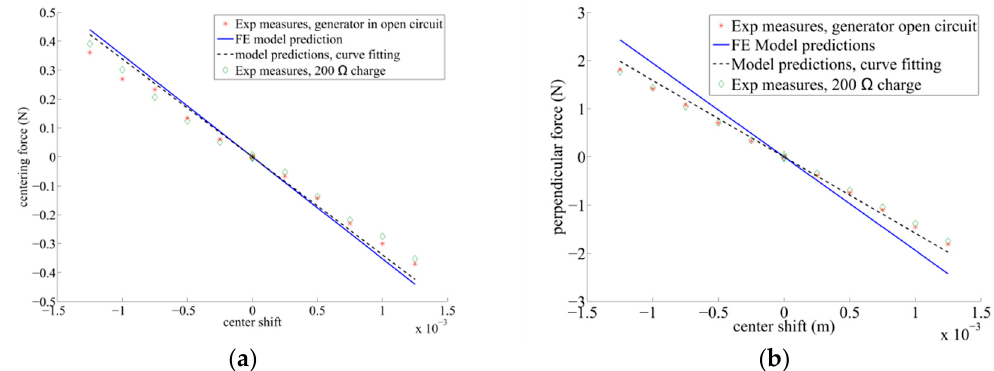
Figure 17. Bearing forces as a function of the rotor displacement (x-axis) for a spin speed of 6000 rpm. Measures when the generator is left in open circuit, and when connected to a 200 Ω charge, and comparison with the model predictions; ( a ) restoring force and ( b ) destabilizing force.